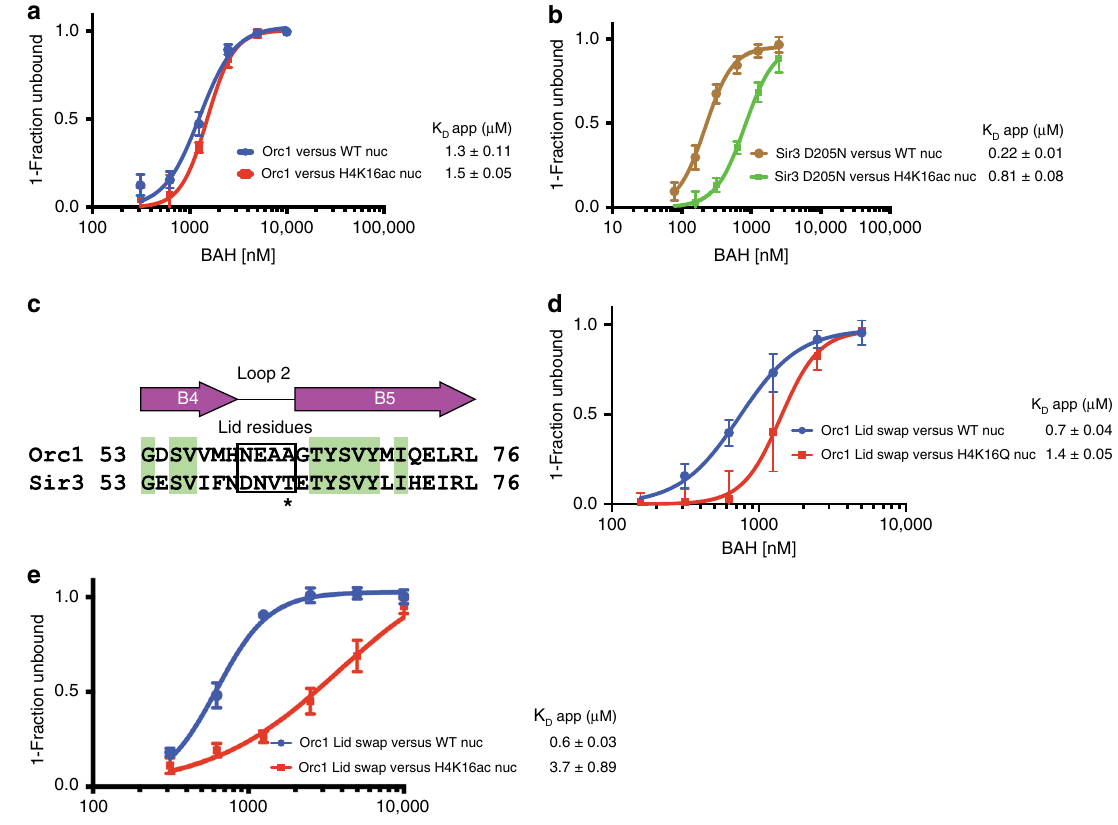
Fig. 3 Orc1 does not discriminate the acetylation state of H4K16. a Binding of Orc1 BAH domain (Orc1) to unmodi fi ed (WT nuc) and H4K16ac nucleosomes measured by EMSA. b Binding of Sir3 D205N BAH domain to unmodi fi ed and H4K16ac nucleosomes measured by EMSA. c Sequence alignment of variable Loop 2 region in Orc1 and Sir3. Loop 2 Lid residues are highlighted in a box. Asterisk represents a dominant loss of silencing mutation in Sir3. d Binding of Orc1 with Sir3-swapped residues in the Lid of Loop 2 to unmodi fi ed or H4K16Q (acetyl mimic) nucleosomes measured by EMSA. e Binding of Orc1 with Sir3-swapped residues in the Lid of Loop 2 to unmodi fi ed and H4K16ac nucleosomes measured by EMSA shows that these residues confer discrimination for H4K16. Each data point and error bar represent the mean ± s.d. from three or more independent experiments. The standard errors of dissociation constants ( K D ) are